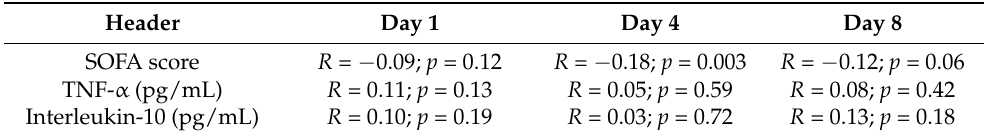
Figure 1. Serum substance P levels in survivor and non-survivor severe septic during the first week. Table 3. Correlations between serum levels of substance P, TNF-α and IL-10, and SOFA score during the first week of severe sepsis.